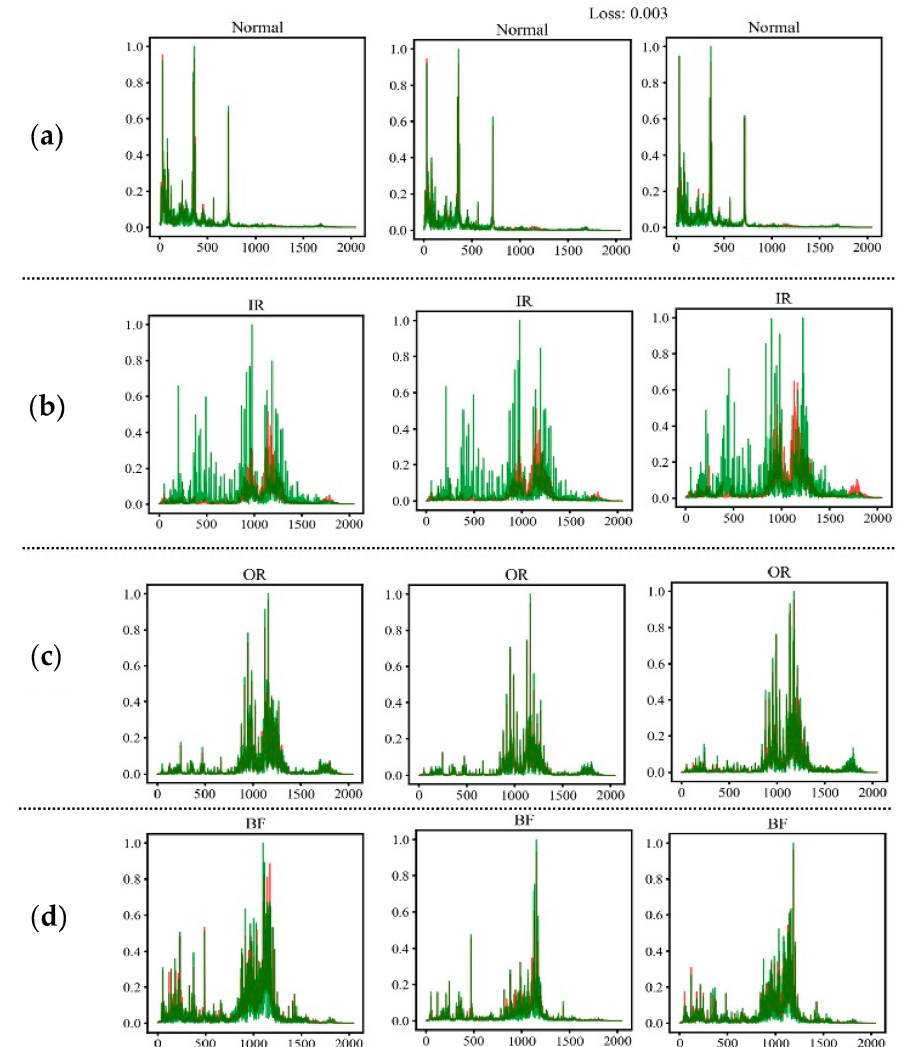
Figure 2. The feature extraction plots from CWRU dataset. ( a ) Normal. ( b ) Inner Race Fault. ( c ) Outer Race Fault. ( d ) Ball